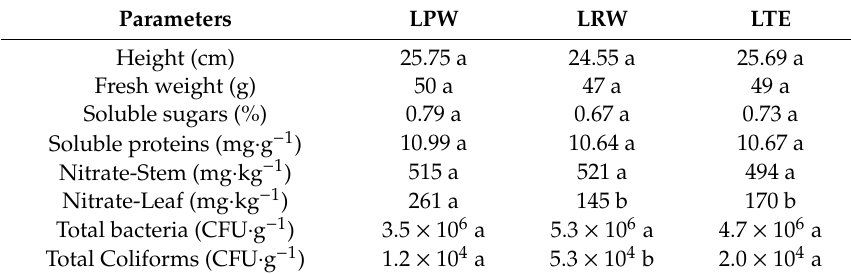
Table 3. Quality and microbiological parameters of lettuces irrigated with potable water (PW), raw wastewater (RW), and treated e ffl uent